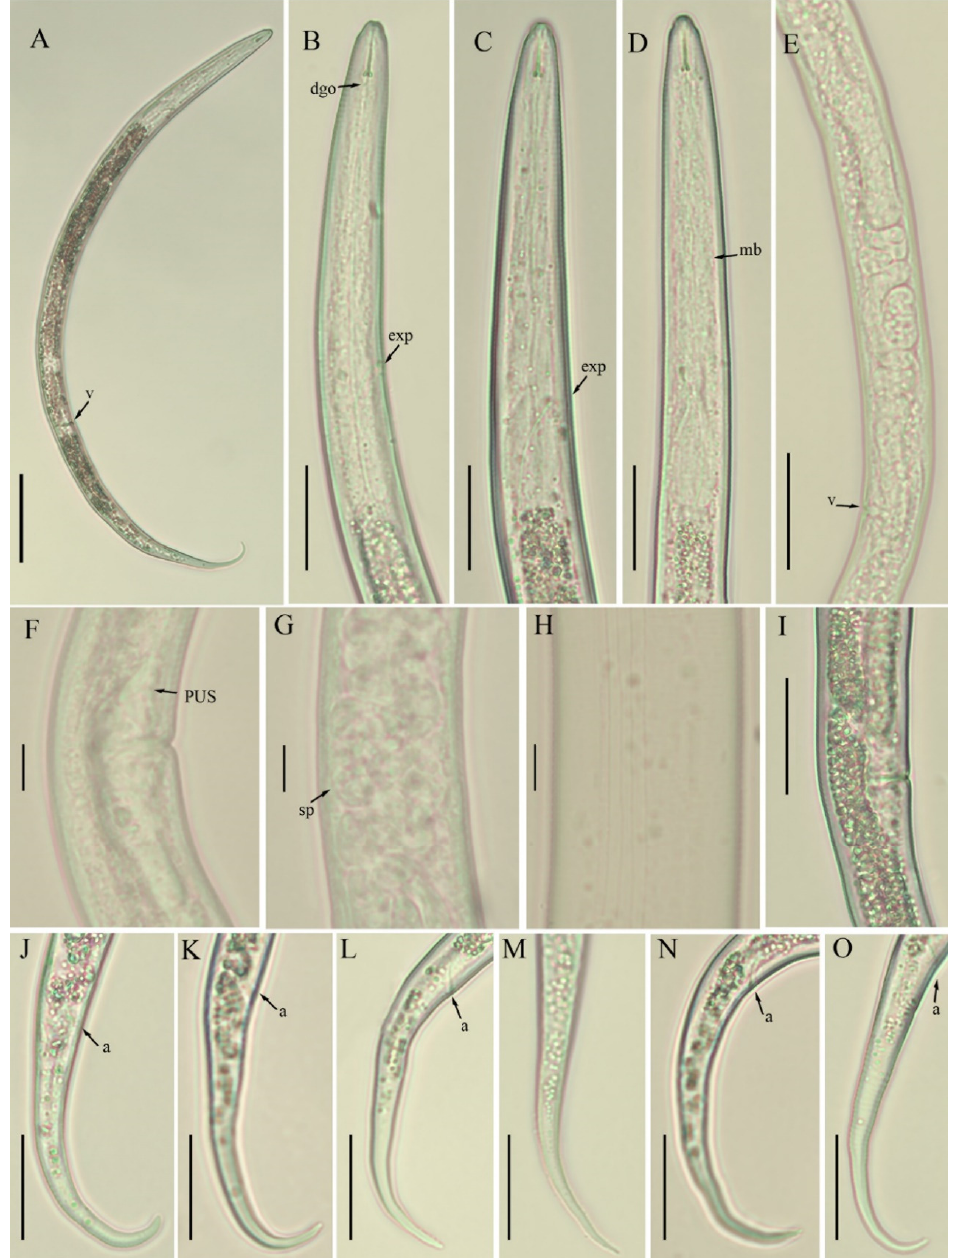
Figure 1. Photomicrographs of Boleodorus thylactus female, Canadian population 61. ( A ) Entire body; ( B – D ) pharyngeal region; ( E ) gonad; ( F ) vulval region; ( G ) spermatheca; ( H ) lateral lines; ( I ) vulval region; ( J – O ) tail regions. Scale bars: ( A ) 50 µm; ( B – E , I – O ) 20 µm; ( F – H ) 5 µm. Arrowheads: (a) anus; (exp) excretory pore; (dgo) dorsal esophageal gland orifice; (mb) median bulb; (sp) spermatheca; (PUS) post uterine sac; (v) vulva.